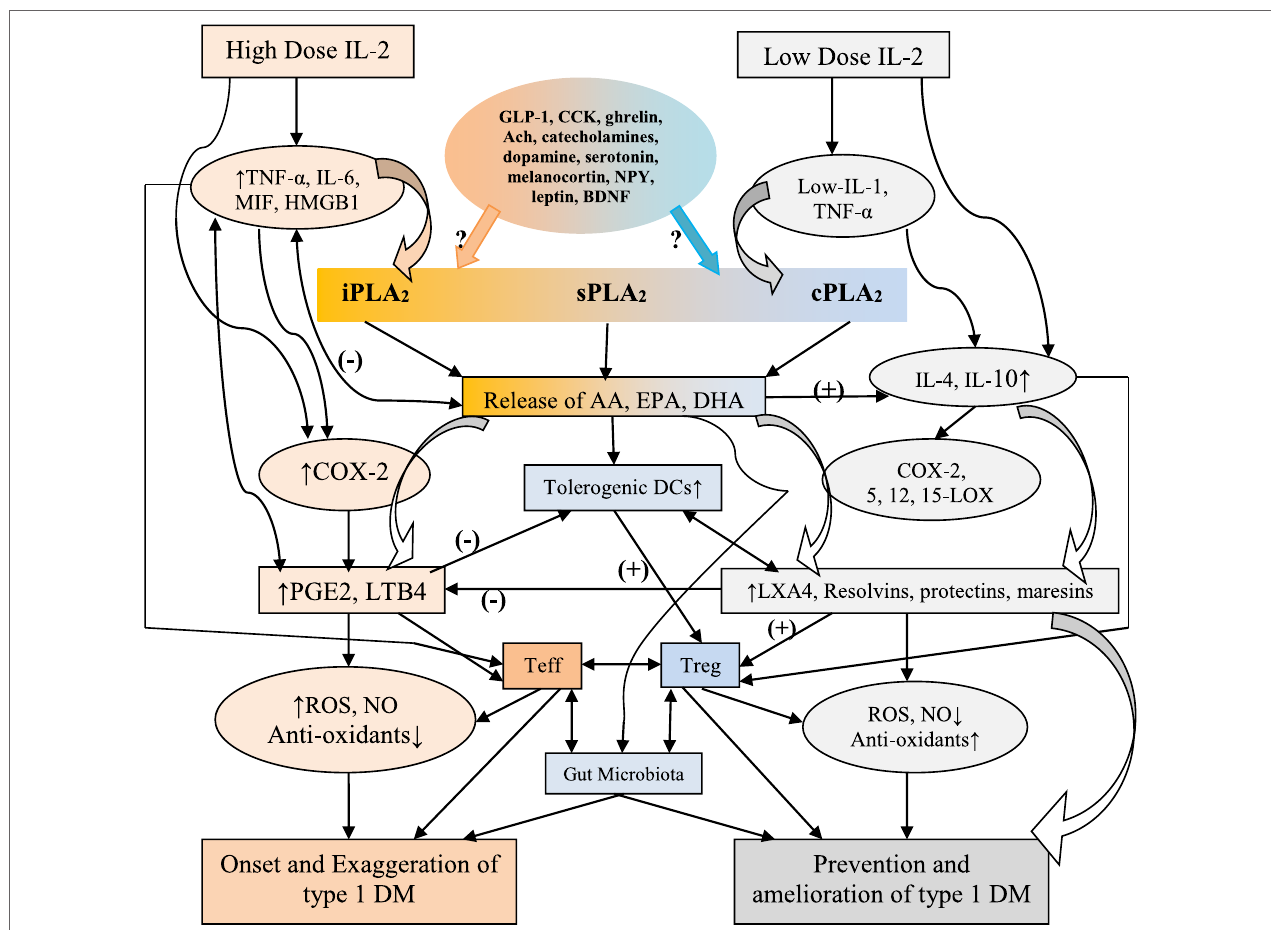
FiGUre 5 | Scheme showing possible interaction among high and low doses of IL-2 in inducing and preventing type 1 diabetes mellitus (type 1 DM). It is proposed that high doses of IL-2 induce the activation of iPLA 2 and COX-2 that leads to the synthesis and release of PGE2 and LTB4 and other pro-inflammatory molecules that enhance the formation of free radicals leading to apoptosis of pancreatic β cells and onset of type 1 DM. On the other hand, low doses of IL-2/tumor necrosis factor- α (TNF- α ) activates sPLA 2 and cPLA 2 (cPLA 2 > sPLA 2 ) that leads to the formation of lipoxins, resolvins, and protectins; anti-inflammatory molecules, which decrease the formation of free radicals and enhance antioxidant capacity of pancreatic β cells and prevents type 1